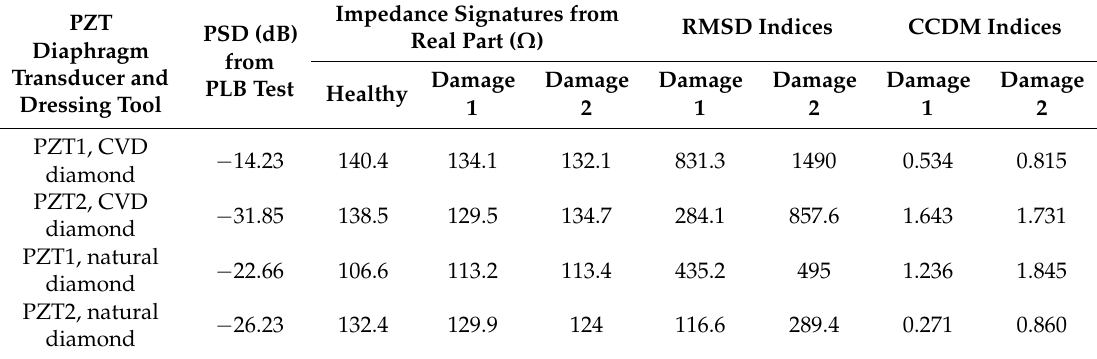
Table 1. Main features obtained from maximum values for each analysis in dressing